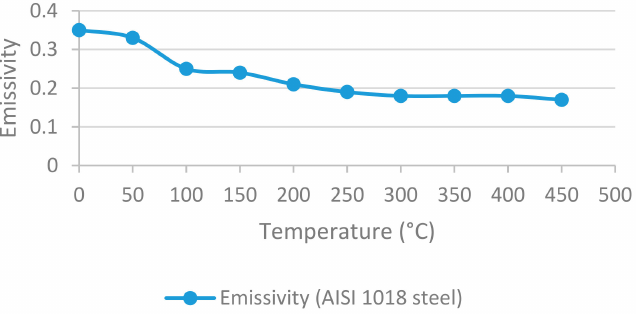
Figure 6. Emissivity as function of temperature for AISI 1018 steel.